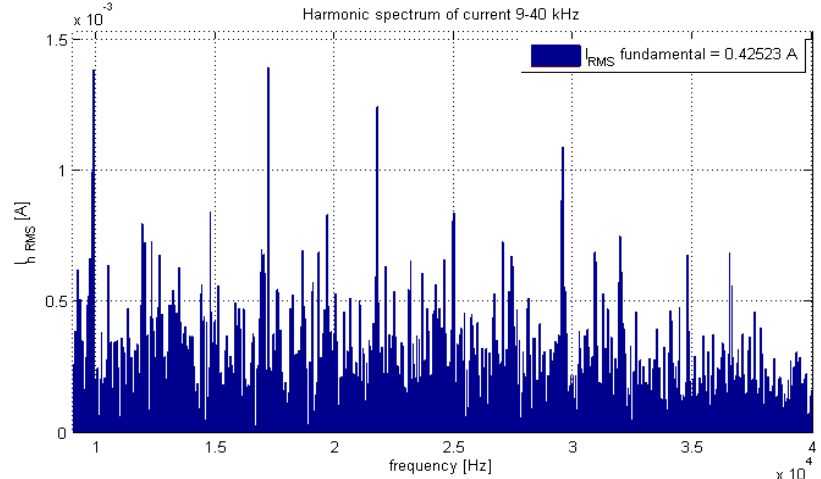
Figure 6. Harmonic decompositions of voltages and currents within the range (9 – 40) kHz: ( top ) — voltage; ( down ) — current. Table 1. Power quality parameters and indices for the recorded electric quantities for case